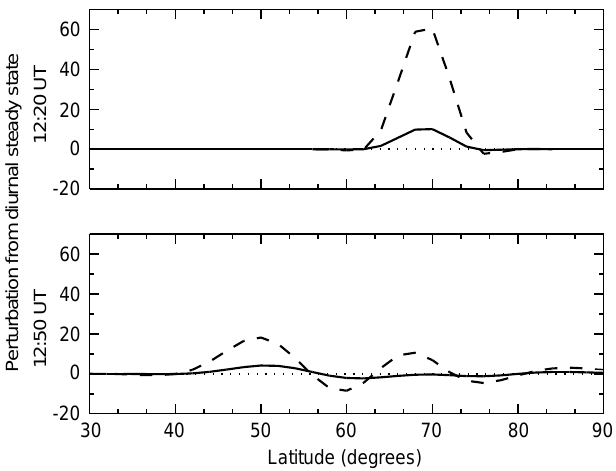
Fig. 1. Perturbations in the height of a fixed pressure level and in neutral temperature from diurnally steady-state conditions. The upper panel gives results for 12.20 UT during a zonal electric field enhancement, and the lower panel for 12.50 UT as the resultant AGW propagates southwards. The solid line shows the change in height of a fixed pressure level at approximately 260 km (with the vertical scale reading as km), while the dashed line shows the change in neutral temperature along that fixed pressure level (with the vertical scale reading as degrees Kelvin). The horizontal dotted line shows the undisturbed steady-state conditions for both quantities (i.e.,